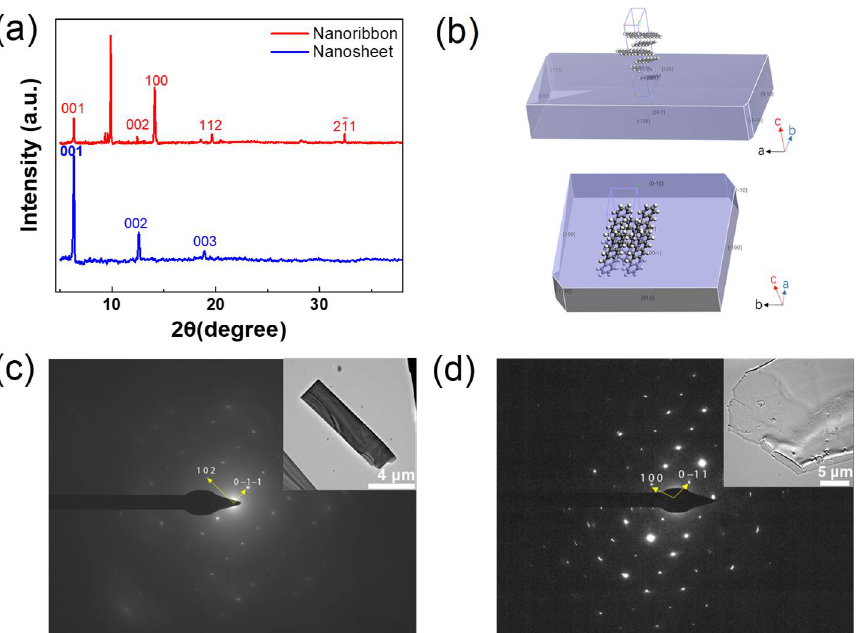
Figure 2. ( a ) XRD patterns of the pentacene nanoribbon crystal (red) and nanosheet crystal (blue). ( b ) Theoretically predicted morphology of the nanoribbon crystal and nanosheet crystal. ( c , d ) Selected-area electron diffraction (SAED) pattern images of pentacene nanoribbon and nanosheet depicting zone axes of (21–1) and (011), respectively. The insets are the corresponding TEM images.